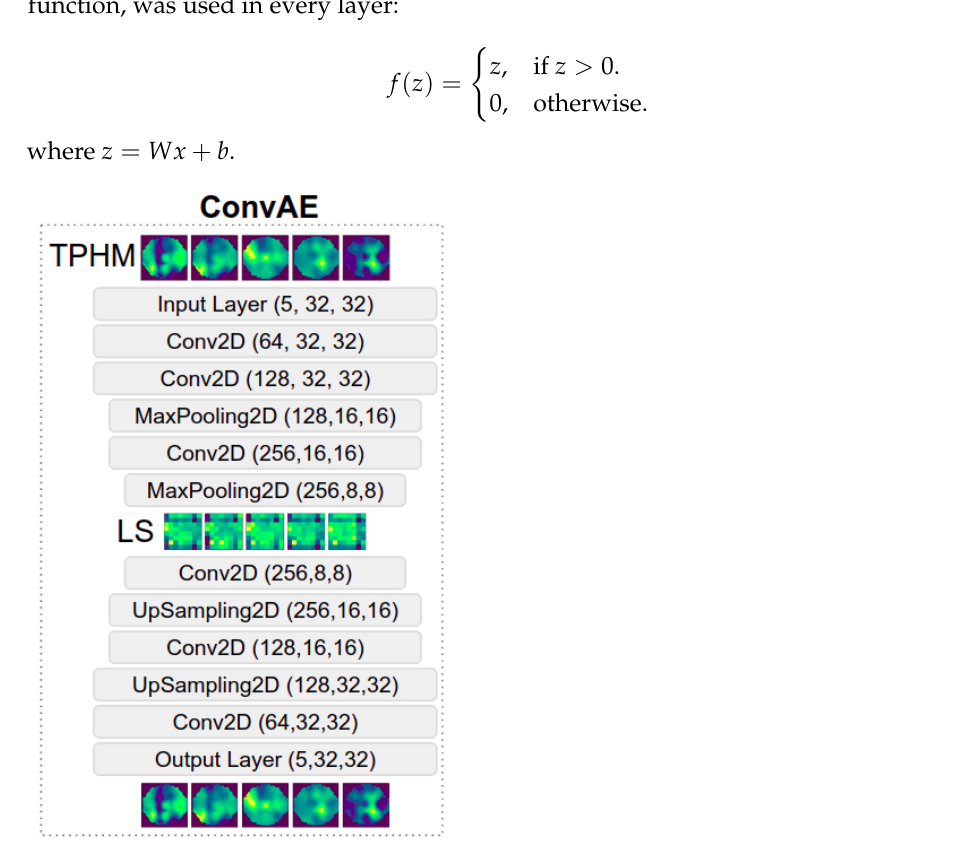
Figure 2. Convolutional Autoencoder’s (ConvAE) architecture for learning optimal latent space (LS) from topology-preserving head-maps (TPHM) for delta, theta, alpha, beta, and gamma EEG